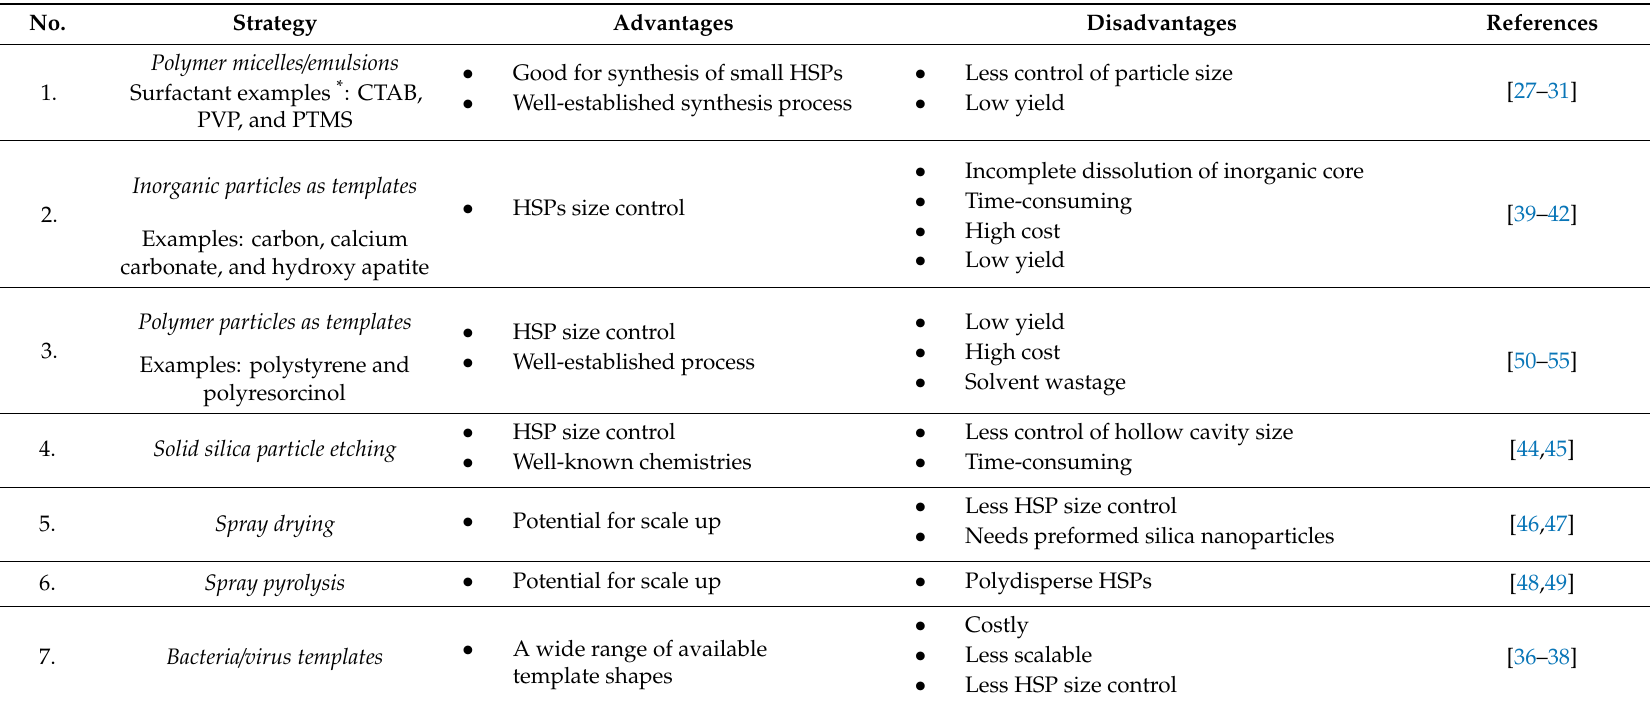
Table 1. Advantages and disadvantages of HSP synthesis